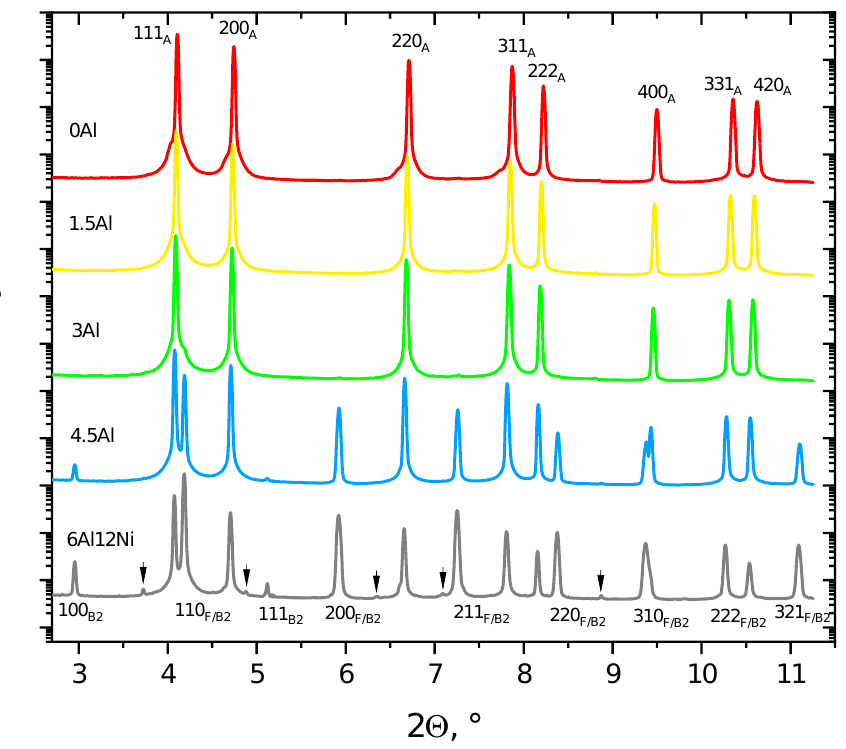
Figure 5. 1D XRD patterns of experimental steels obtained by post-processing of 2D diffraction patterns. Specimens were obtained by homogenization, double-step cold rolling and recrystallization annealing of cast ingots. Arrows indicate weak reflections likely due to hexagonal M 7 C 3 carbides.